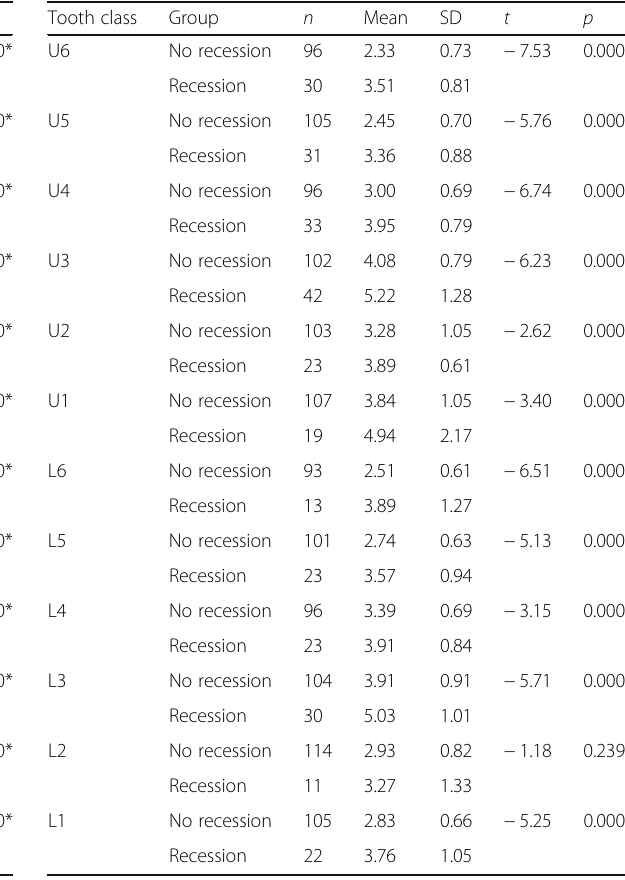
Table 4 Independent t -tests comparing the no recession to recession subgroups using the gingival margin-papillae measure for the combined four